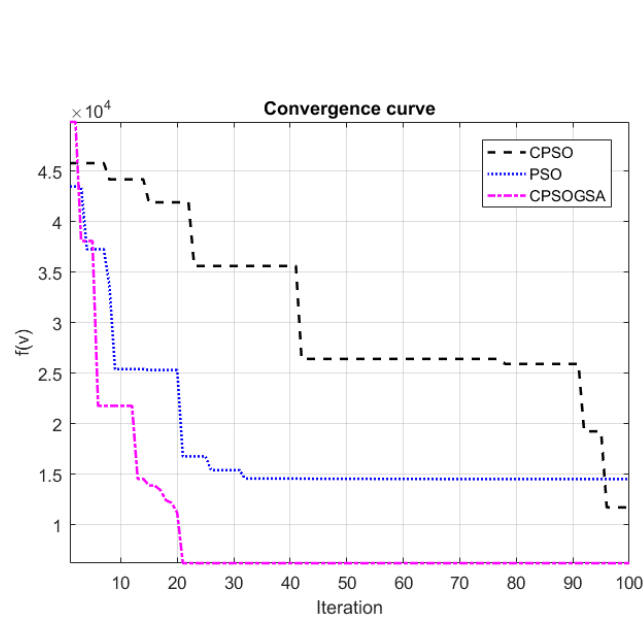
Figure 6. Convergence Curve Comparison for PSO, CPSO and PSOCGSA